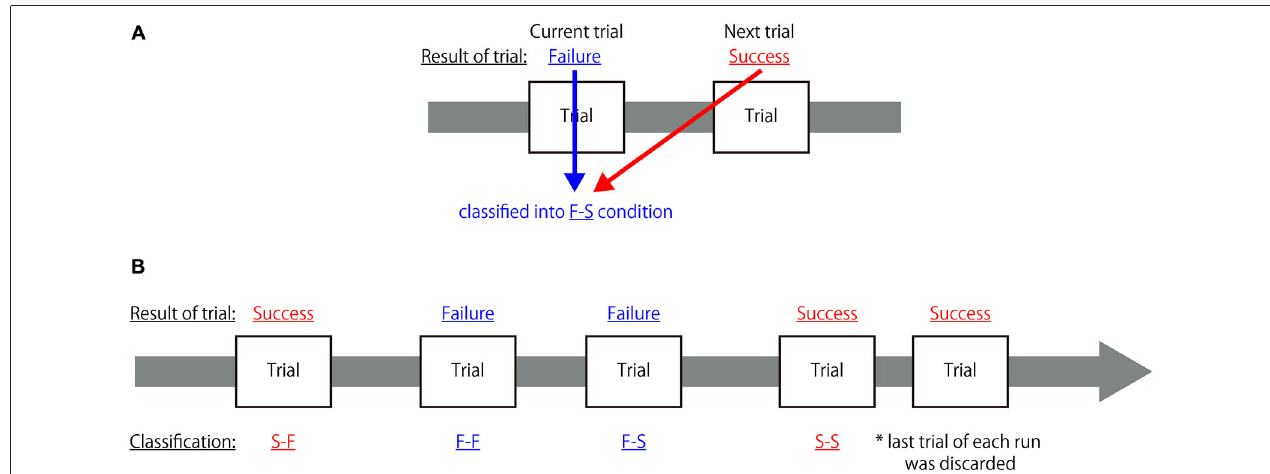
FIGURE 2 | Classification criteria for each trial in the first-level analysis. (A) Sample explanation for the classification of a two-trial combination. If the participant failed to correctly respond to the current trial (Failure) but responded correctly to the subsequent trial (Success), that trial was classified as belonging to the F-S condition. (B) Example of classification of a combination of five trials. Each trial was classified into one of the four categories but, because the last trial of each run did not have a subsequent trial, it was not classified as belonging to any of these categories and was discarded from further